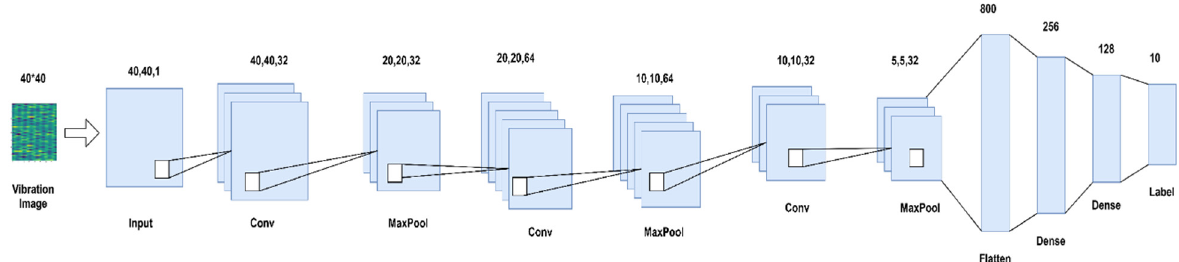
Figure 8. Network architecture of 2-D CNN model used for comparison.